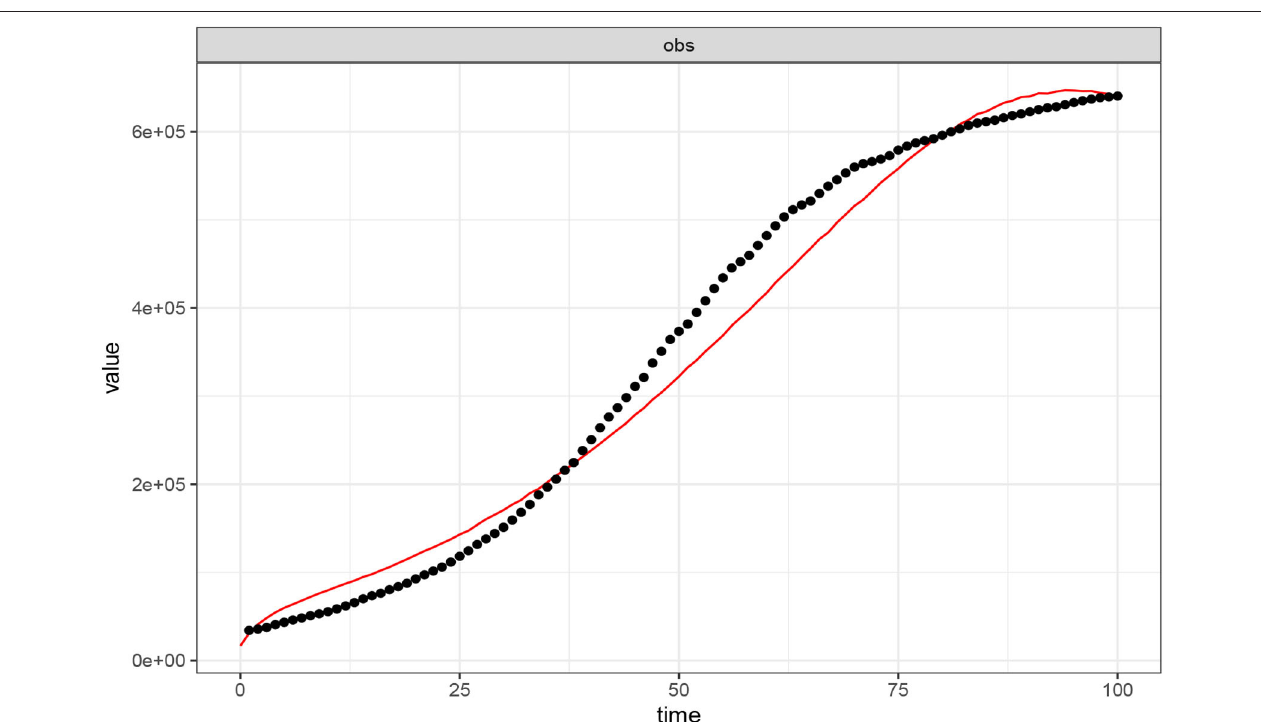
FIGURE 2 | Calibration of the model (Equations 2–8) to COVID-19 positive reported cases (01 June–08 September, 2020) in the Republic of South Africa. The black dotted line shows the reported data while the red-continuous line depicts the model’s goodness of fit. Parameter values used are as listed in Table 1 where ω = 0.00001, α = 0.00001, and σ =